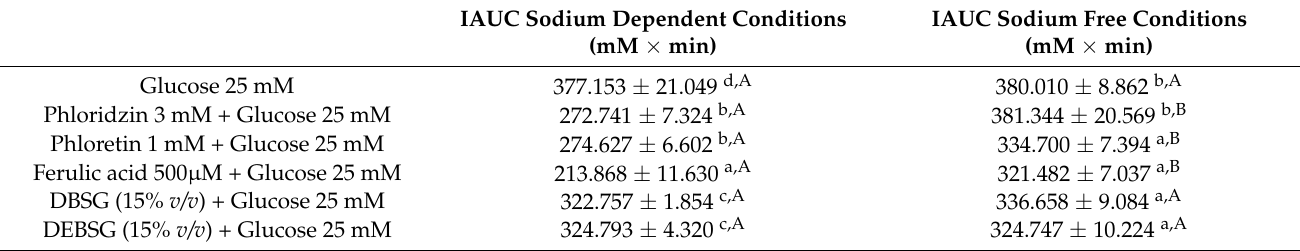
Table 9. Incremental area under the curve for glucose absorption inhibition models.